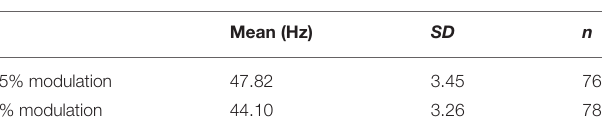
Frontiers in Human Neuroscience |